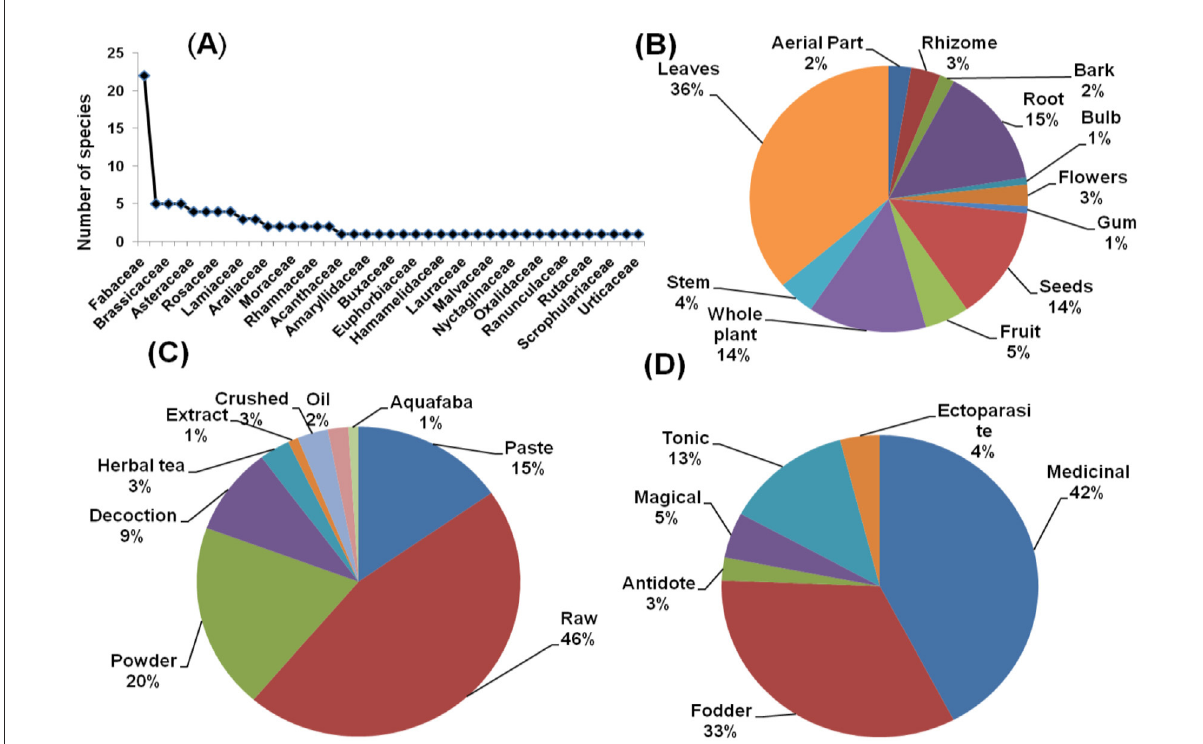
FIGURE4 (A) Species family relationship (B) part used (C) form of preparation (D) ethno-veterinary usage of plants from Jammu